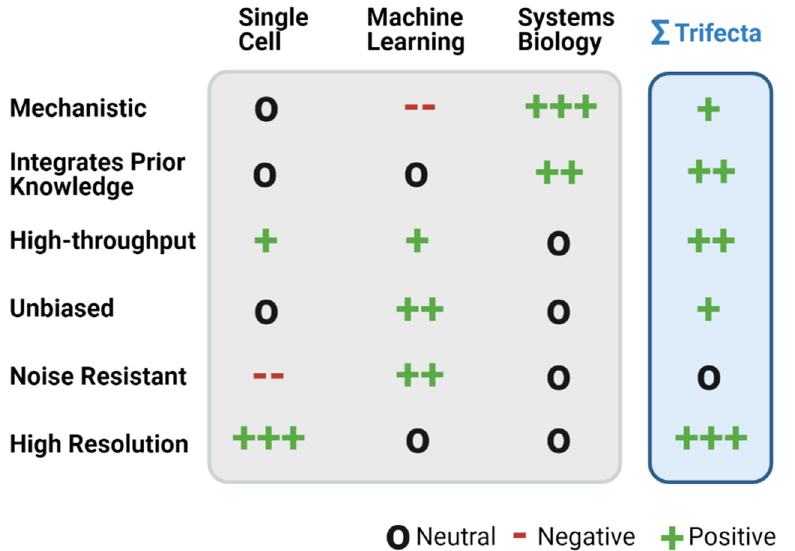
Figure 1. Strengths and weaknesses of the trifecta and their combinatorial benefits. A summary chart of the strengths (green) and weaknesses (red) of machine-learning, systems-biology, and single-cell omics in key areas of challenge or need (rows). The blue trifecta column highlights how combined negatives are countered and more needs are met. (Created with BioRender).